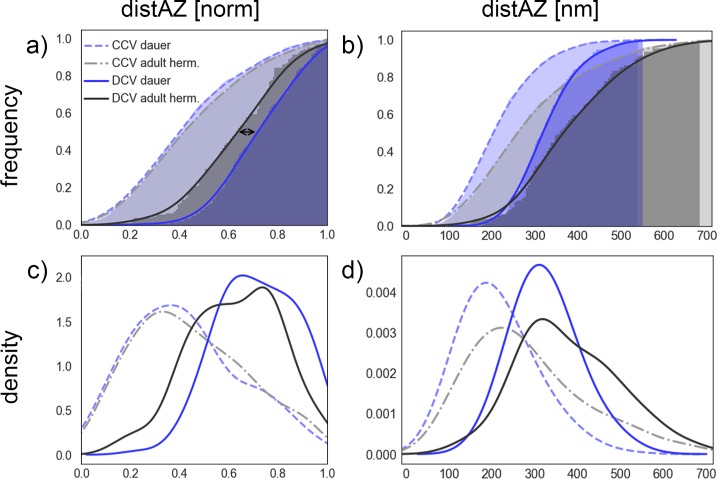
Cumulative histogram (a, b) and kernel density estimation (smoothed histogram) plots (c, d; bandwidth = 0.07*maximum value of total dataset) of distances to the active zone (distAZ). Given are normalized distances (left) and real values in nm (right). CCVs are shown as dashed line and DCVs as continuous line. Adult hermaphrodite vesicles are presented in shades of gray, whereas dauer larval vesicles are shown in violet. All plots are based on expert curated manual ground truth classification.